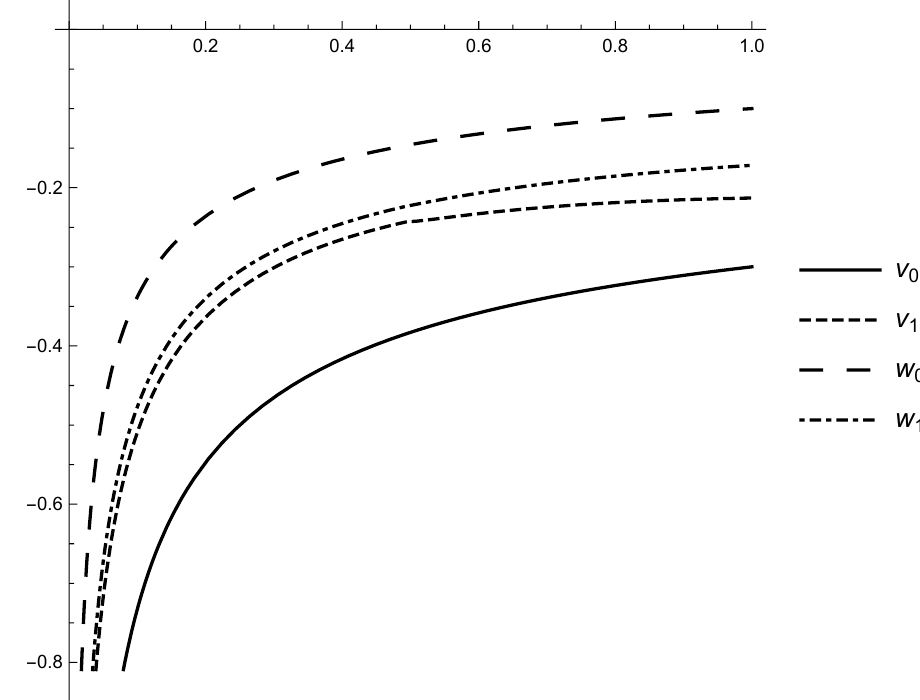
Figure 11. Example 2. Graphs of the functions α i ( t ) and β i ( t ) , i =